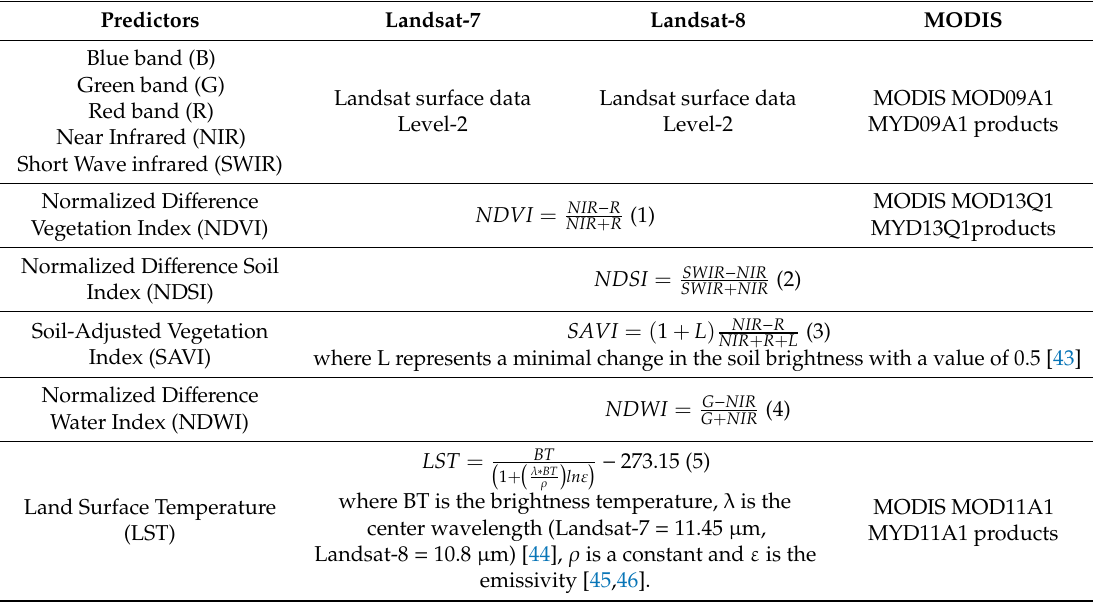
Table 2. Remote sensing predictors used to build the model for each